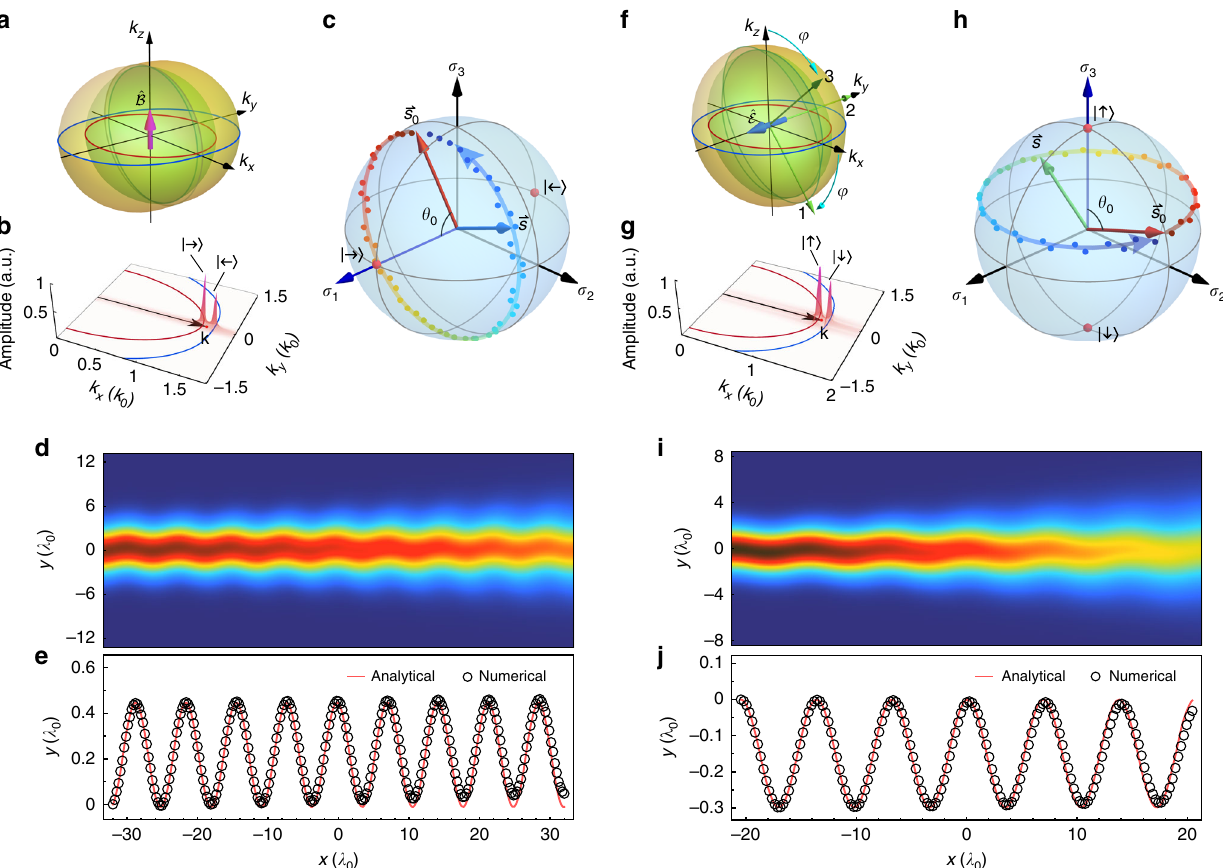
Fig. 1 Zitterbewegung effect in homogeneous non-Abelian media. a – e ZB induced by a synthetic non-Abelian magnetic fi eld in a gyrotropic medium with $ ε μ (cid:6) the parameters ε $ T ¼ μ $ 1 : 5 I 1 : 5, g 0 : 3 i ; (cid:2) 0 : 07 Þ > . This medium produces a synthetic SU(2) magnetic fi eld along z direction, z ¼ 2 ´ 2 , 1 ¼ (cid:2) g 2 ¼ ð T ¼ z ¼ ^ ^ B ¼ (cid:2) k 2 0 0 : 042 e z ^ σ 3 , with a null SU(2) electric fi eld E ¼ 0. f – j ZB induced by a synthetic non-Abelian electric fi eld in a biaxial non-magnetic medium with the parameters ε 1 ¼ 1 : 65, ε 2 ¼ 2 : 45, ε 3 ¼ 3, and μ = μ 1. The synthetic SU ð 2 Þ electric fi eld, ^ E ¼ (cid:2) k 3 0 : 08919 e y ^ σ 2 , is along the y -aixs, while the SU(2) 0 0 ¼ magnetic fi eld vanishes ^ B ¼ 0. a , f The isofrequency surfaces and their xy cross sections (red and blue curves) of both cases. The green arrows in f are the three principal axes 1, 2, 3 of permittivity tensor. b , g Fourier spectra in k -space of the beams in the two media. In each case, the two peaks in the spectrum correspond to the two eigenmodes with wave vectors in the x direction. And the average wave vectors k are marked by the black arrows. c , h The